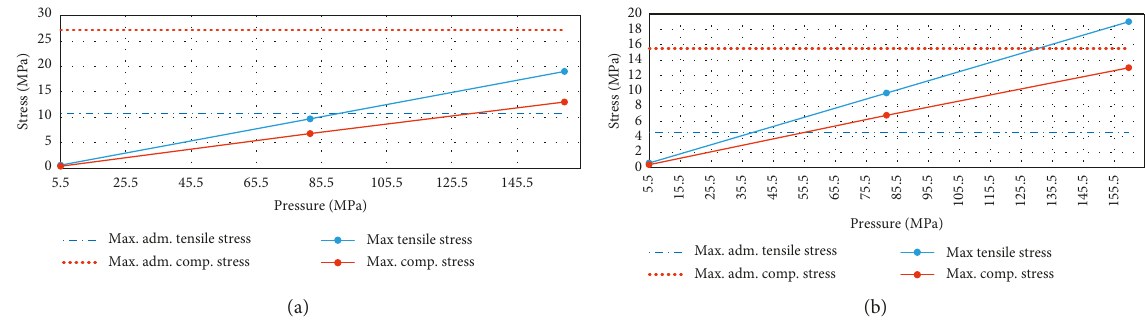
Figure 14: Comparison between maximum tensile and compressive stresses and maximum admissible tensile and compressive stresses for (a) Utility Structure 1 (b) Utility Structure 2 as a function of